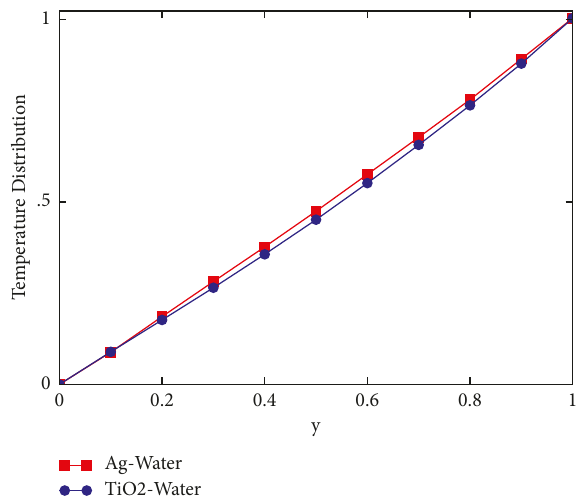
6 . 2, t 0.4, Gr 40, Q 0.5, M 10, β 2 and α (cid:30) (cid:30) (cid:30) (cid:30) (cid:30) (cid:30)